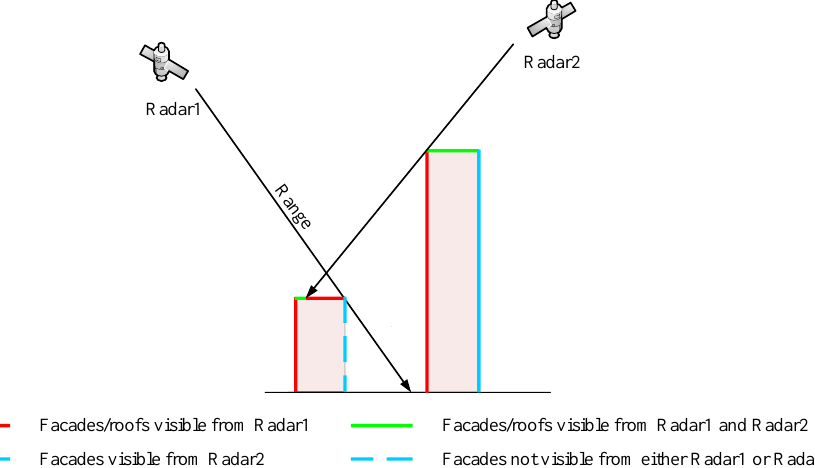
Figure 1. Illustration of multi-view observation of combined buildings. The back of the lower building is always